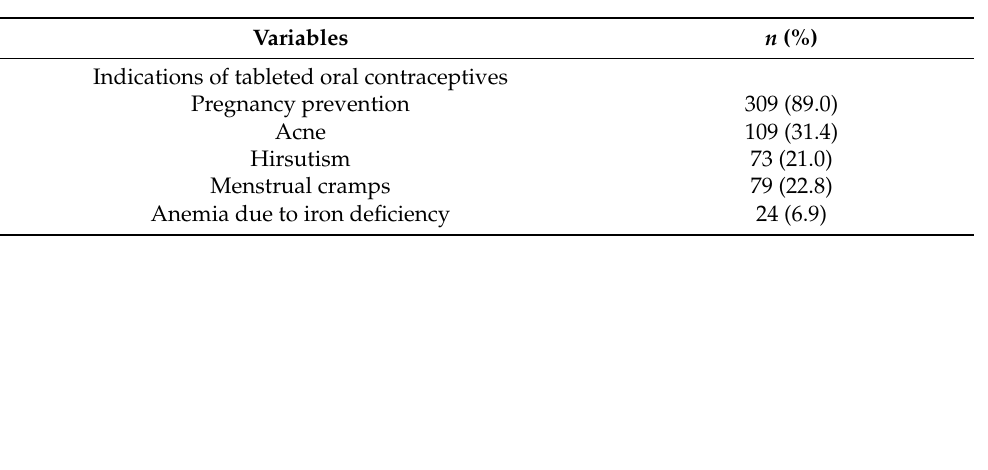
Table 2. The general knowledge of the CPs regarding oral